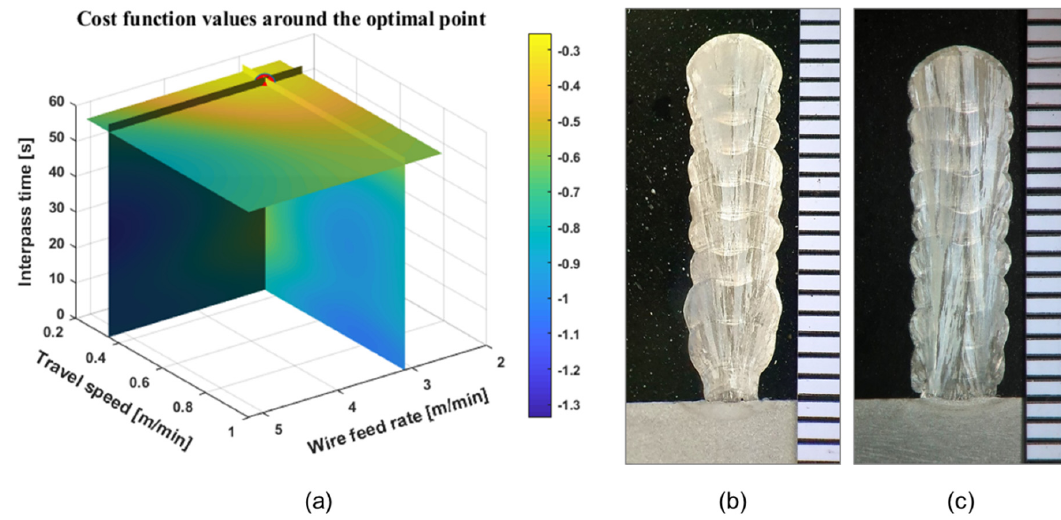
Figure 8. ( a ) The cost function and ( b ) fusion zone shapes before optimization and ( c ) after optimization. To verify the possibility of hitting a local minimum, 20 di ff erent initial points were arbitrarily selected and executed for comparison. All the comparison results represent the final output values, 𝐱 ∗ = (cid:4670)3.1002 0.3522 57.972(cid:4671) (cid:3021) − 8 limited by the tolerance threshold of 1 × 10 , which are delivered to the optimizer as